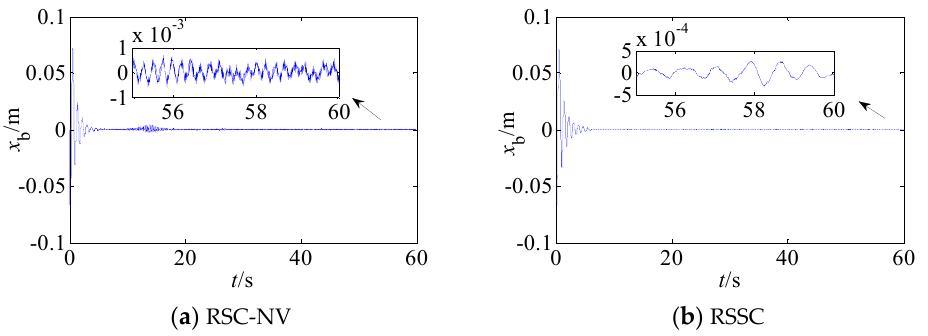
Figure 5. Elastic vibration curve of the system base.